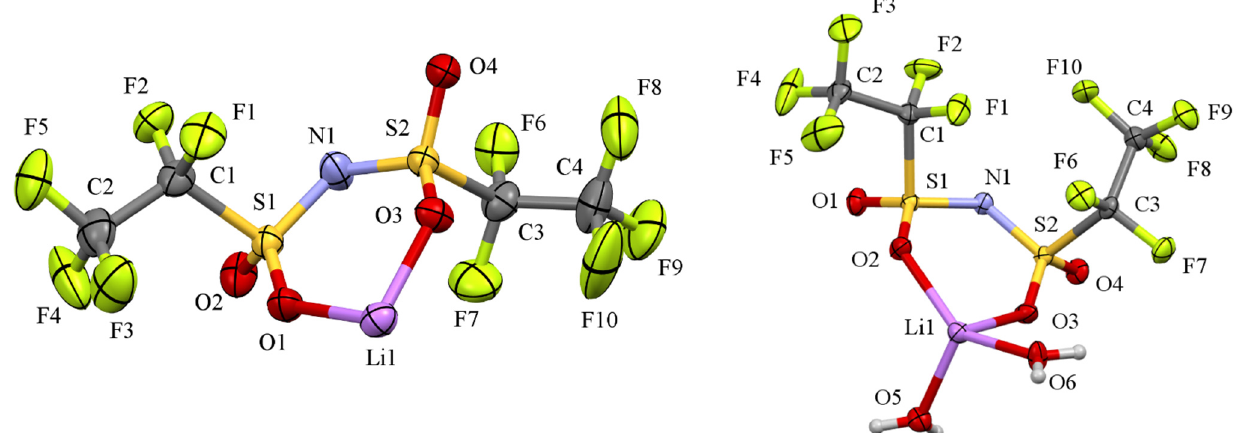
Figure 2. Asymmetric units of [Li{BETI}] ( left ) and [Li{BETI}(H 2 O) 2 ] ( right ) shown with 50% probability ellipsoids. Gray, carbon; green, fluorine; red, oxygen; pink, lithium; yellow, sulfur; blue, nitrogen. Several potential factors influence the distances and interactions in the two